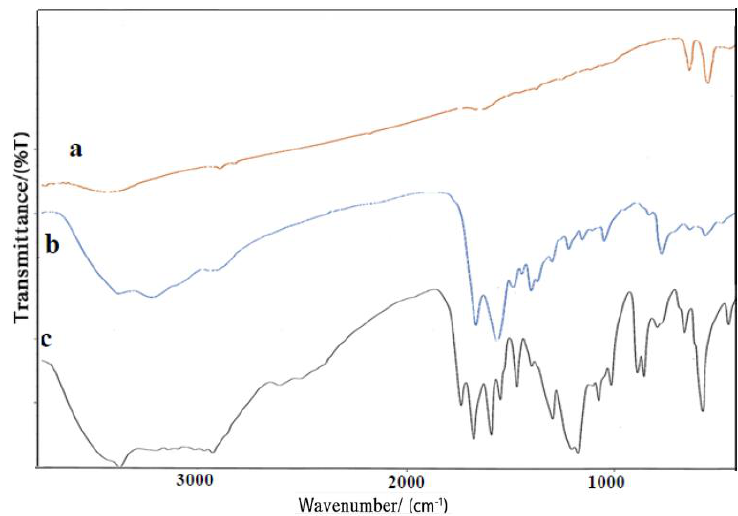
Fig. 5. FT-IR of (a) Co